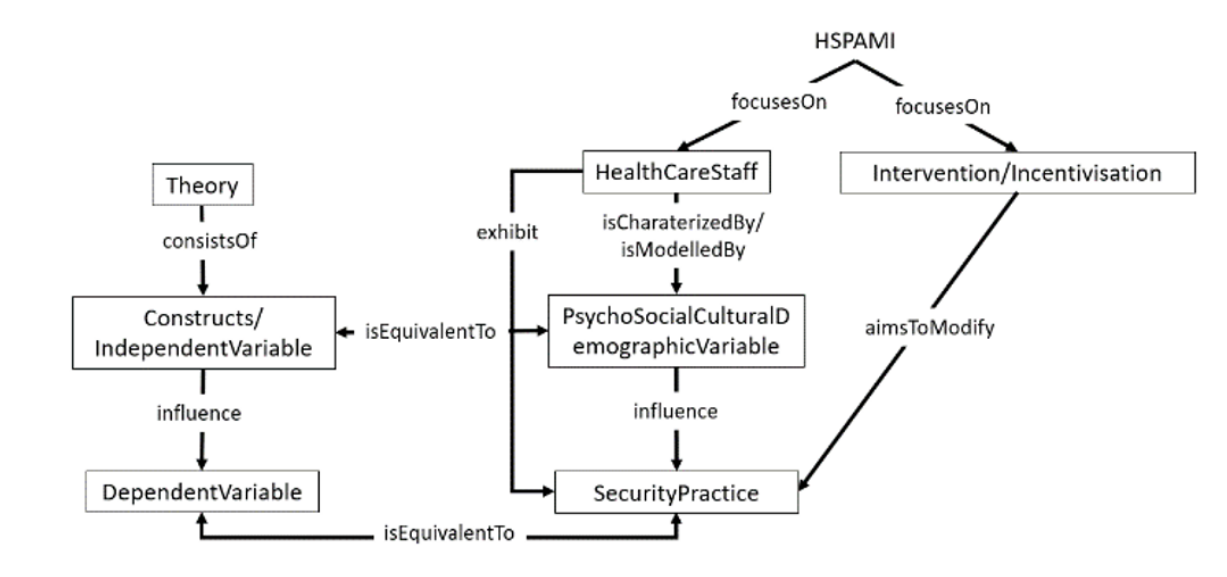
Figure 3. Structure of the ontology representing concepts as classes and specifying the relationship among the classes. The relationships among concepts are represented by the arrows between concepts in the rectangles. HSPAMI: Healthcare Security Practice Analysis, Modeling, and